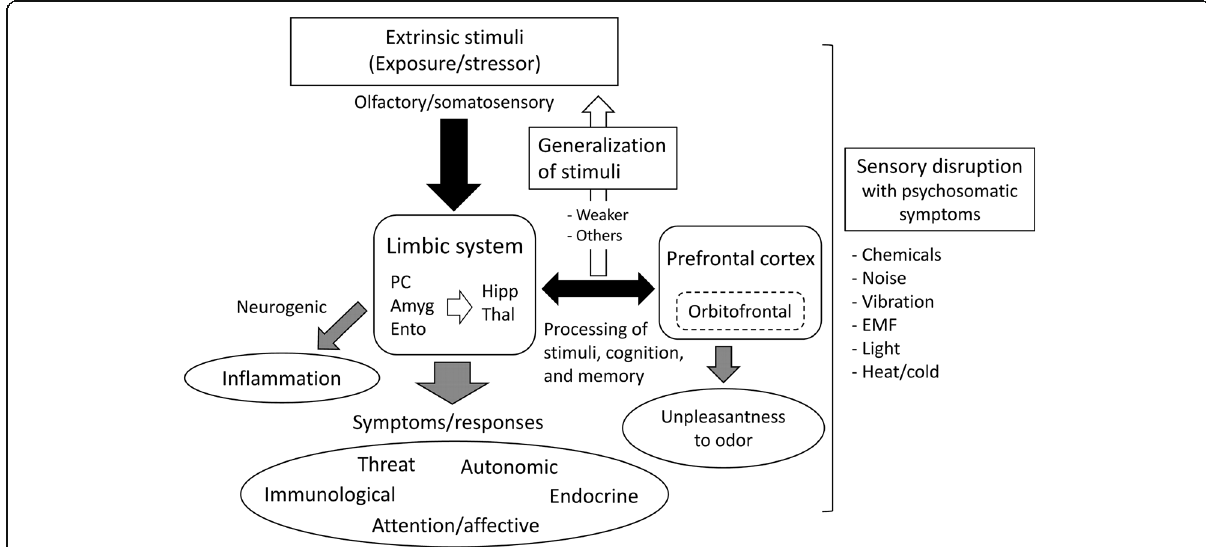
Fig. 2 Sensory and cognition model of the interrelationships among stimulus factors, limbic system, cortices, symptoms, and responses. Abbreviations: Amyg, amygdala; EMF, electromagnetic field; Ento, entorhinal cortex; Hipp, hippocampus; PC, piriform cortex; Thal,